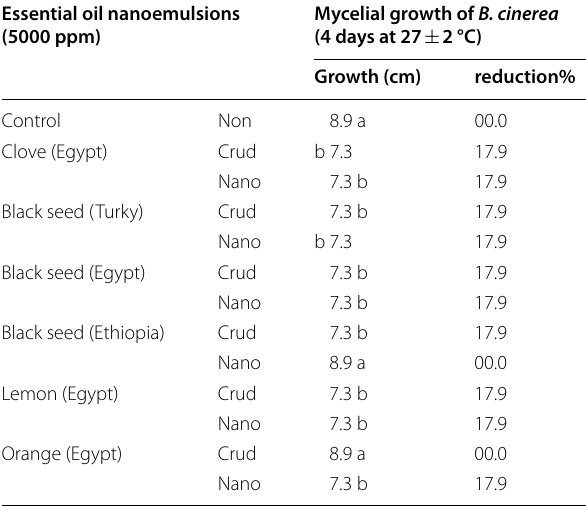
Table 1 Effect of some essential oils and their nanoemulsion on growth of B. cinerea